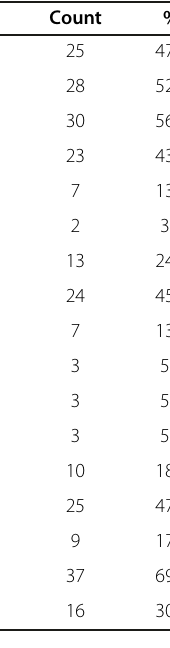
Table 1 Socio-demographic characteristics of study